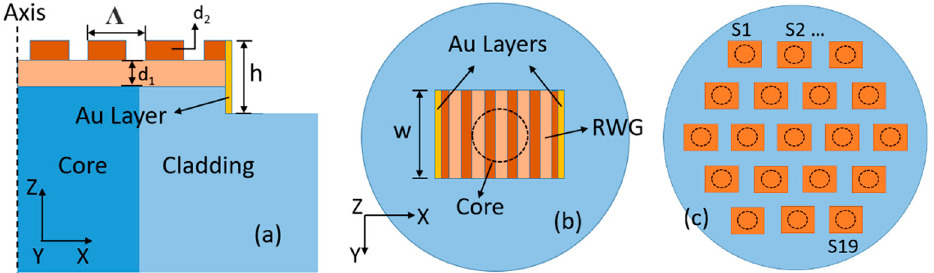
Figure 2. Schematic of the designed fiber-tip RWG sensor: ( a ) cross-section perpendicular to the grating lines, ( b ) top view, and ( c ) multiplexed sensor array on the facet of a typical 19-core fiber. ( a ) The black dashed line represents the central (core) axis of the fiber, and only half of the sensor’s geometry is presented for simplicity.